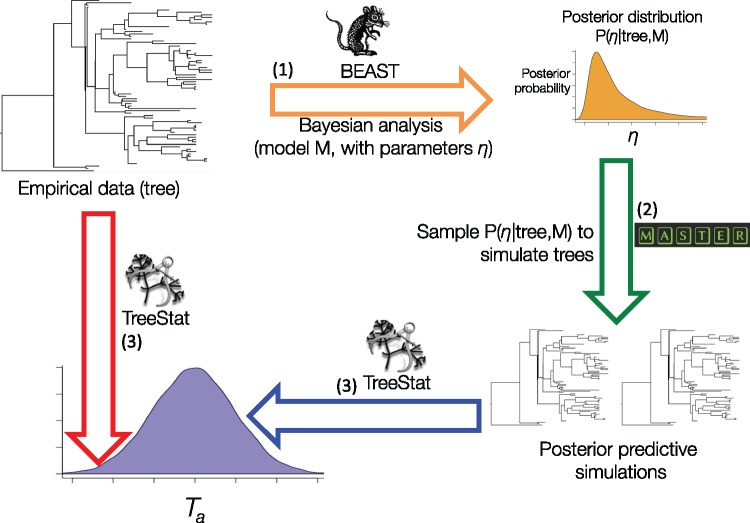
Posterior predictive simulation framework implemented in the TreeModelAdequacy package. Step (1) consists in Bayesian analysis in BEAST under model M to estimate the posterior distribution of parameters \documentclass[12pt]{minimal}
\usepackage{amsmath}
\usepackage{wasysym}
\usepackage{amsfonts}
\usepackage{amssymb}
\usepackage{amsbsy}
\usepackage{upgreek}
\usepackage{mathrsfs}
\setlength{\oddsidemargin}{-69pt}
\begin{document}
}{}$\eta $\end{document}, shown with the arrow and posterior density in orange. In step (2), samples from the posterior are drawn to simulate phylogenetic trees, known as posterior predictive simulations, using MASTER as shown by the green arrow. In step (3), the posterior predictive simulations are analyzed in TreeStat to generate the posterior predictive distribution of test statistic \documentclass[12pt]{minimal}
\usepackage{amsmath}
\usepackage{wasysym}
\usepackage{amsfonts}
\usepackage{amssymb}
\usepackage{amsbsy}
\usepackage{upgreek}
\usepackage{mathrsfs}
\setlength{\oddsidemargin}{-69pt}
\begin{document}
}{}$T_{a}$\end{document}, shown by the blue arrow and probability density. Finally, \documentclass[12pt]{minimal}
\usepackage{amsmath}
\usepackage{wasysym}
\usepackage{amsfonts}
\usepackage{amssymb}
\usepackage{amsbsy}
\usepackage{upgreek}
\usepackage{mathrsfs}
\setlength{\oddsidemargin}{-69pt}
\begin{document}
}{}$T_{a}~$\end{document}is also computed for the tree from the empirical data using TreeStat, shown by the red arrow, to calculate a posterior predictive probability (\documentclass[12pt]{minimal}
\usepackage{amsmath}
\usepackage{wasysym}
\usepackage{amsfonts}
\usepackage{amssymb}
\usepackage{amsbsy}
\usepackage{upgreek}
\usepackage{mathrsfs}
\setlength{\oddsidemargin}{-69pt}
\begin{document}
}{}$P_{B})$\end{document}. Test statistics and \documentclass[12pt]{minimal}
\usepackage{amsmath}
\usepackage{wasysym}
\usepackage{amsfonts}
\usepackage{amssymb}
\usepackage{amsbsy}
\usepackage{upgreek}
\usepackage{mathrsfs}
\setlength{\oddsidemargin}{-69pt}
\begin{document}
}{}$P_{B}$\end{document} values can also be computed for trees generated in other programs using TreeModelAdequacyAnalyser, given that the tree from the empirical data and the posterior predictive simulations are provided.